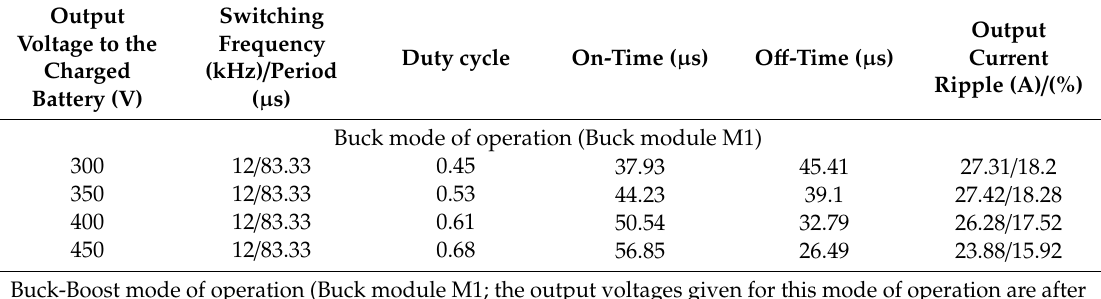
Table 2. Buck-Boost converter time